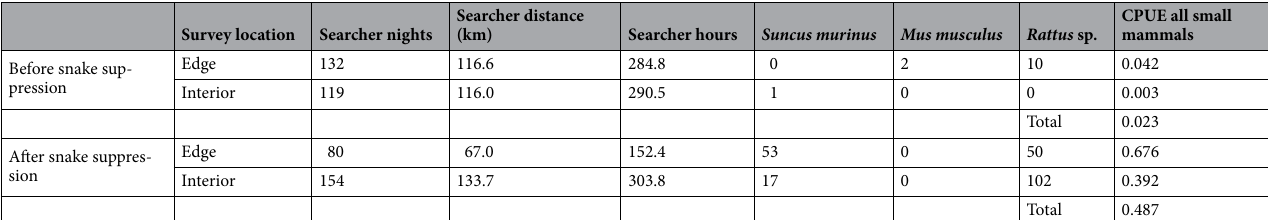
Table 1. Visual survey results of small mammal encounters in the Habitat Management Unit (HMU) before snake suppression (March 2010–September 2012 and March 2013–August 2013) and after snake suppression (31 May 2015 to 6 August 2015). Catch per unit effort (CPUE) is defined as total small mammals encountered/ survey-person